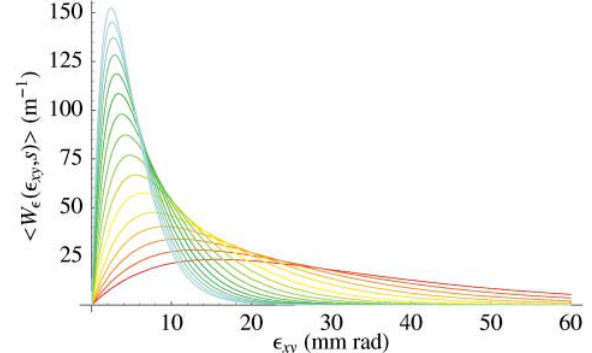
FIG. 7. (Color) Density distribution in the ´ xy variable, at inter- vals of five periods along the channel, from period 0 to period 75. The plots are color coded according to the spectrum, vary- ing from red to blue as the period number varies from 0 to 75.